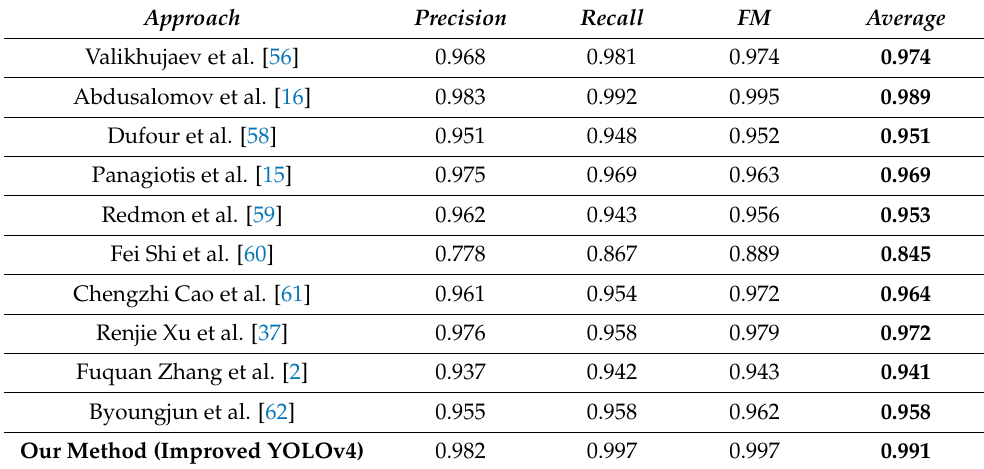
Table 7. Quantitative results of fire detection